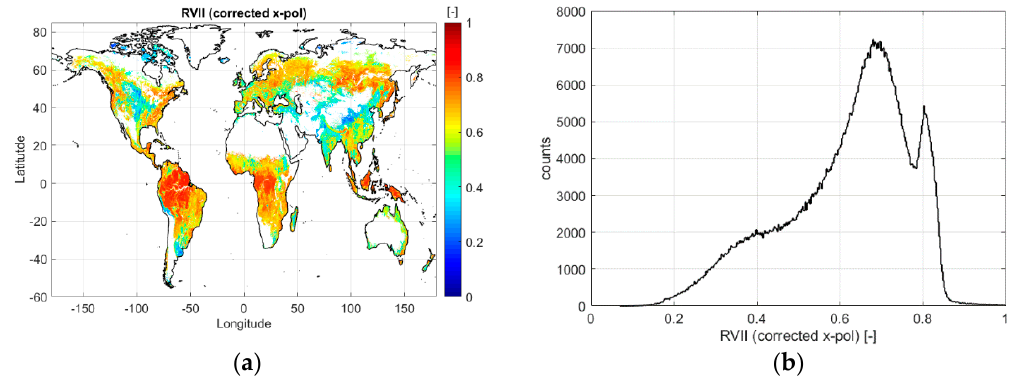
Figure 8. Result of the averaged (April–July 2015) RVII [-] calculated with (8): ( a ) global map; ( b ) histogram of values ranging only between zero and one.